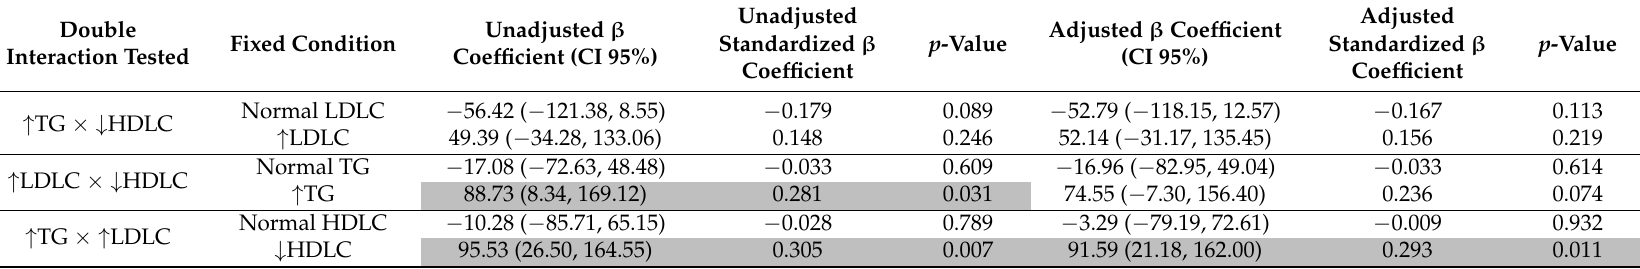
Table 5. Subanalysis of the triple interaction between ↑ TG, ↑ LDLC, and ↓ HDLC and PON1